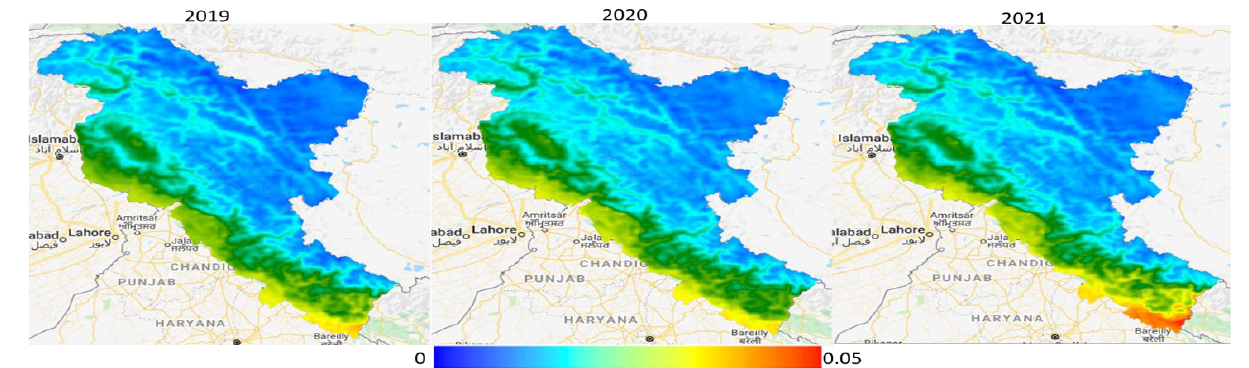
Figure 4. Concentration of NO 2 , CO and UV AI in the Western